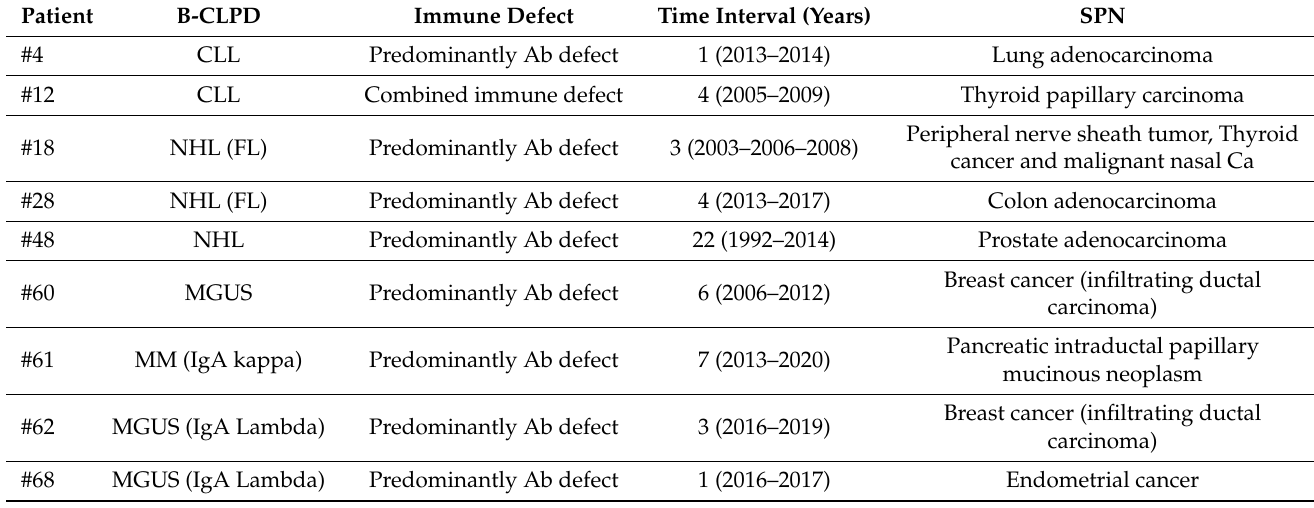
Table 3. Time interval between diagnosis of B-CLPD and a second primary neoplasia diagnosis in our cohort of B-CLPD patients.